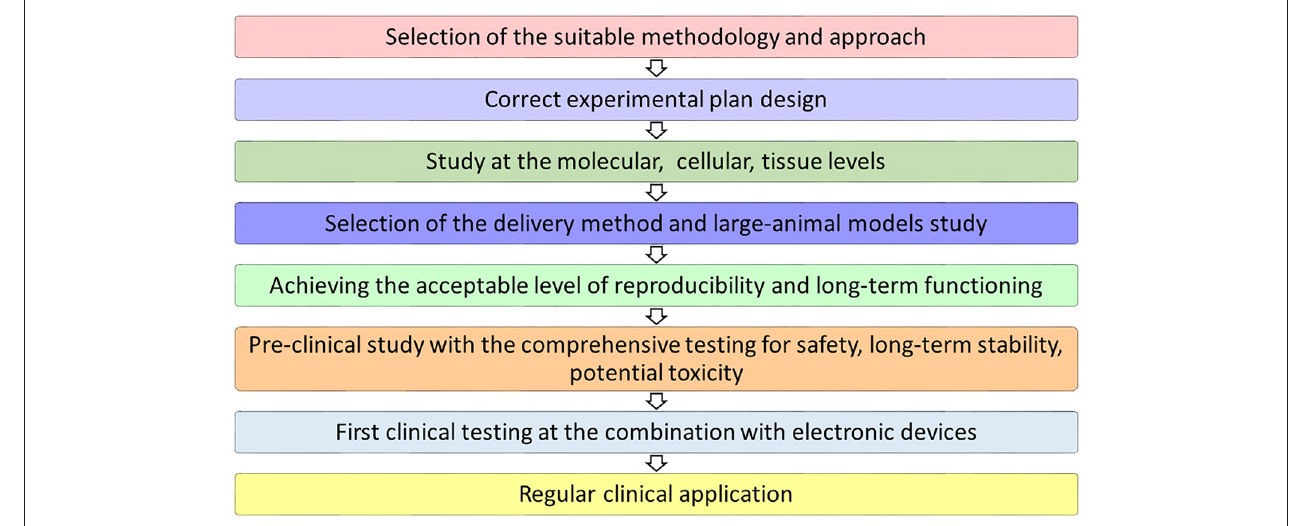
FIGURE 1 | Milestones for the clinical translation of a bioengineered